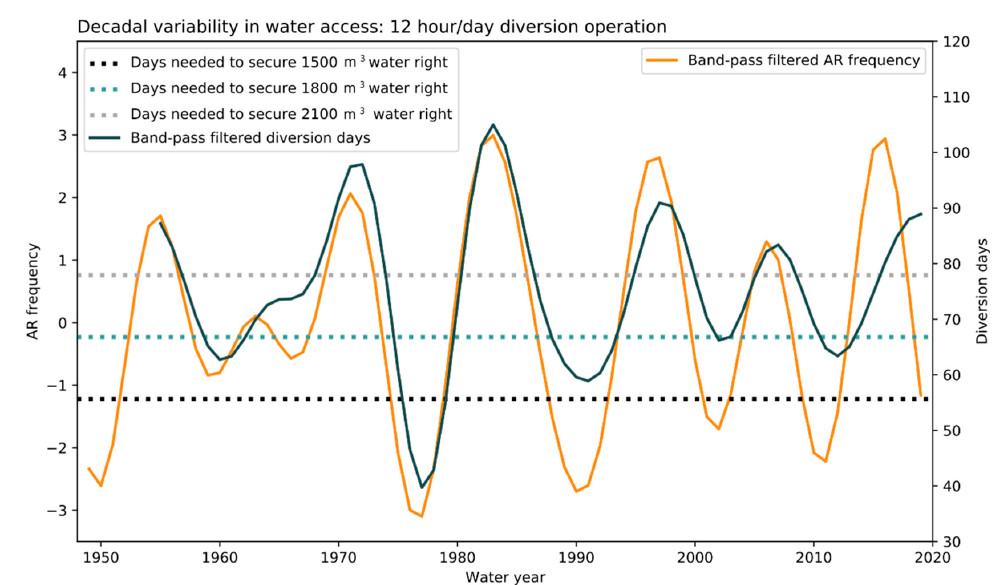
Figure 6. Band-pass filtered (8–20 year) AR frequency and diversion days (contours). AR frequency spans 1948–2019, while diversion days calculated from 11 USGS gauges with a long enough period of record are displayed from 1954–2019. The days needed to secure different water rights at a 12 h/day diversion operation are shown as horizontal dotted lines.